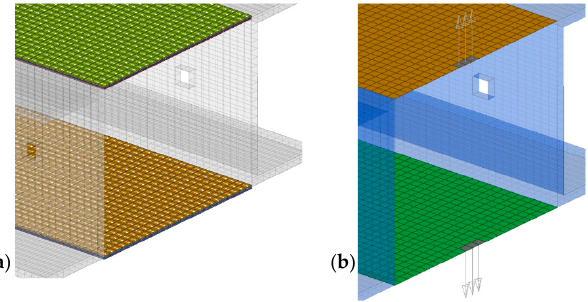
Figure 4. ( a ) Upper and lower plates visualized as a laminate stack; ( b ) normal direction for upper and lower plates shell elements.